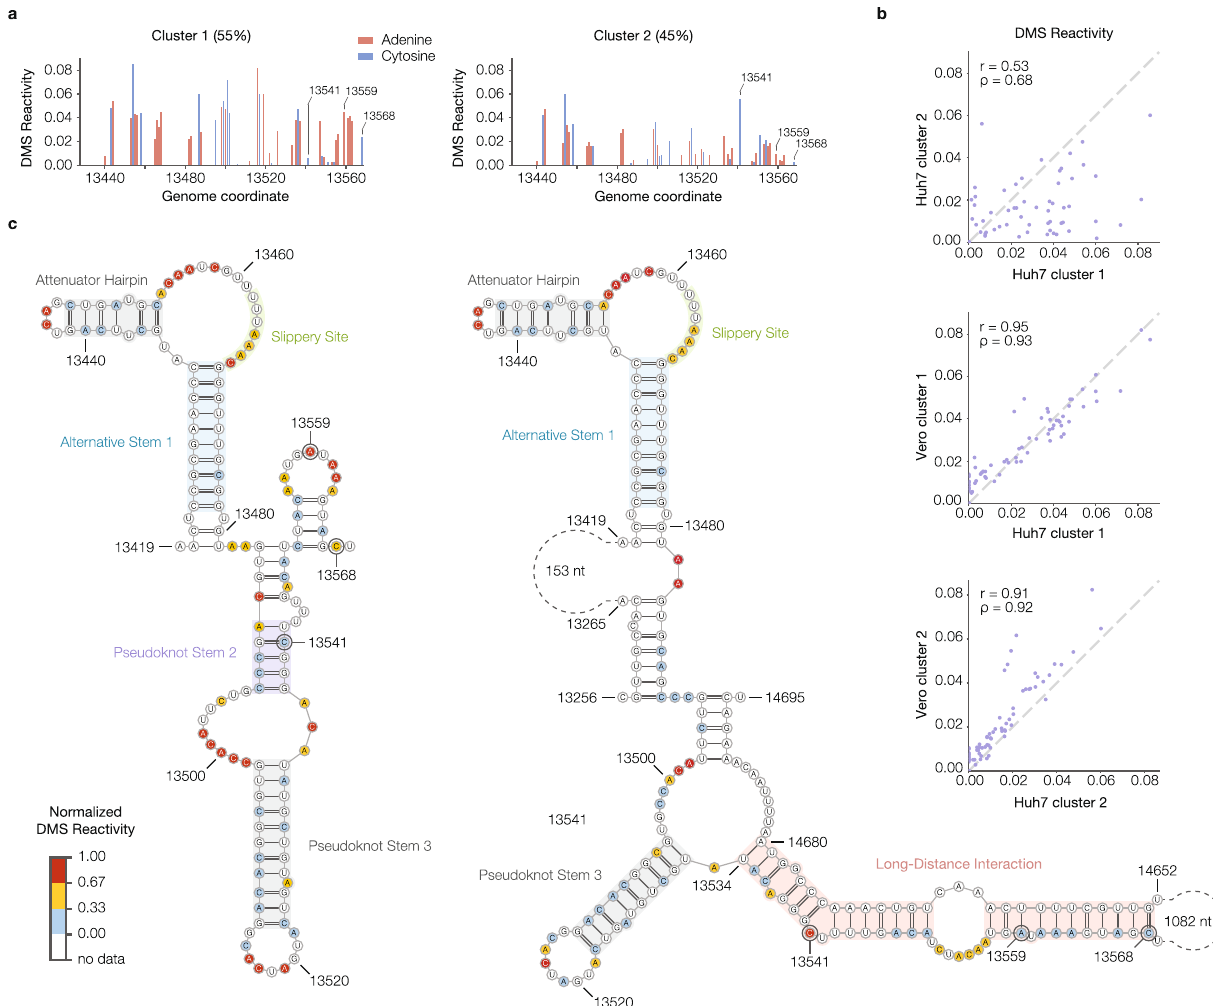
Fig. 5 Alternative conformations of the frameshifting stimulation element (FSE) derived from in-cell DMS-MaPseq data include a long-distance interaction. a DMS reactivity pro fi les for both clusters from the Huh7 genome-wide RT-PCR data in the vicinity of the FSE (nucleotides 13,434 – 13,568). The abundance of each cluster is given beside its name. Each bar representing an adenine or cytosine is colored in red or blue, respectively. Three of the nucleotides whose reactivities differ substantially between clusters are labeled. b Scatterplots of DMS reactivities over the FSE, comparing the two clusters from Huh7 (top) and each Huh7 cluster with the corresponding cluster from Vero cells (middle and bottom). For each comparison, the Pearson ( r ) and Spearman ( ρ ) correlation coef fi cients are given. c Predicted structures of Huh7 clusters 1 and 2 based on DMS reactivities. In each structure, selected features are highlighted, including alternative stem 1 (in both clusters), a long-distance interaction (in cluster 2), and features that are also present in the canonical pseudoknot. The three nucleotides labeled in ( a ) are also labeled in the structure models. Nucleotides are colored by normalized DMS reactivities. Source data are provided as a Source Data fi